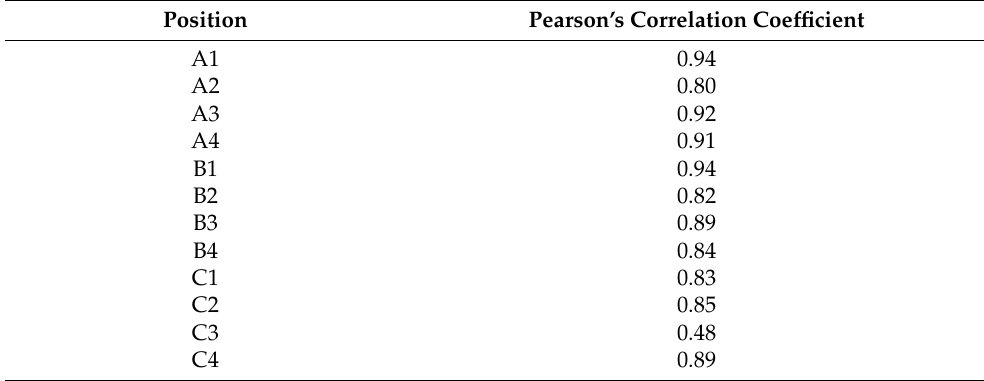
Table 2. Correlation coefficients between strain profiles at VW extensometers